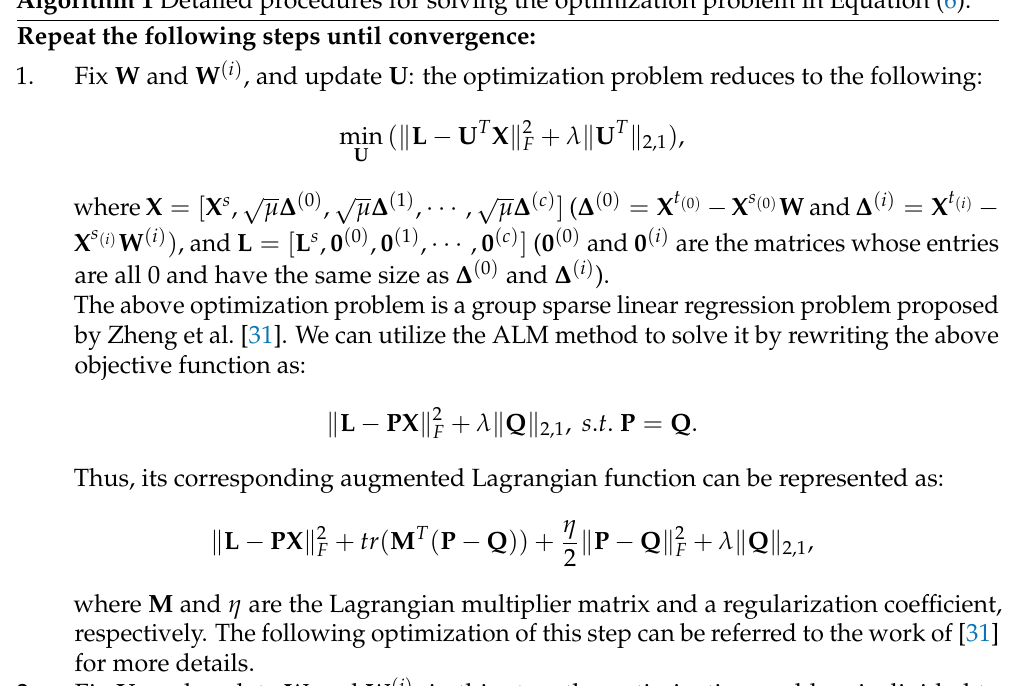
Algorithm 1 Detailed procedures for solving the optimization problem in Equation